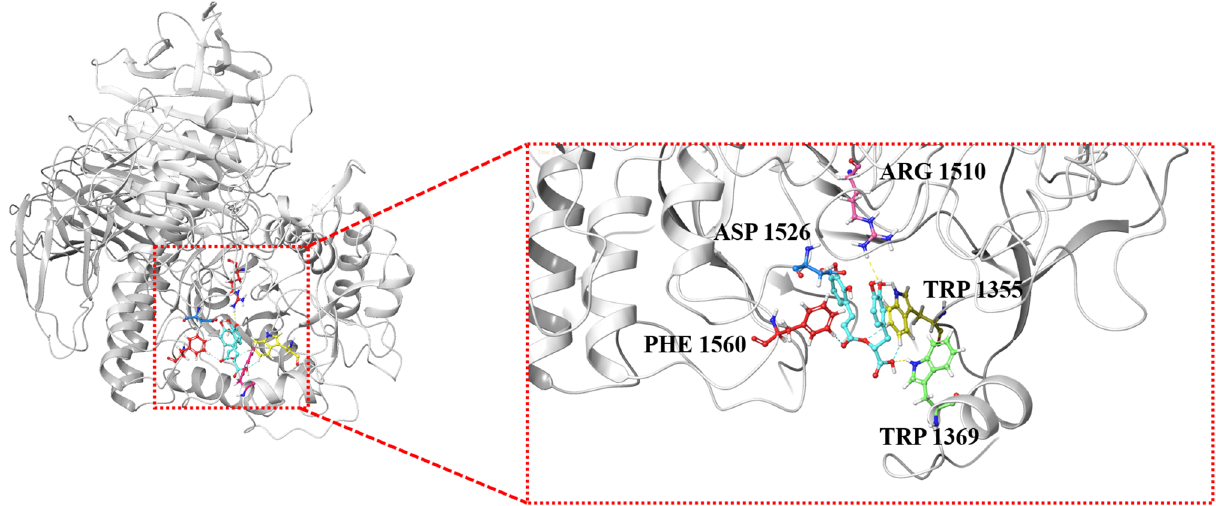
Figure 7. Molecular docking models of α-glycosidase and compound 3 with overall and enlarged